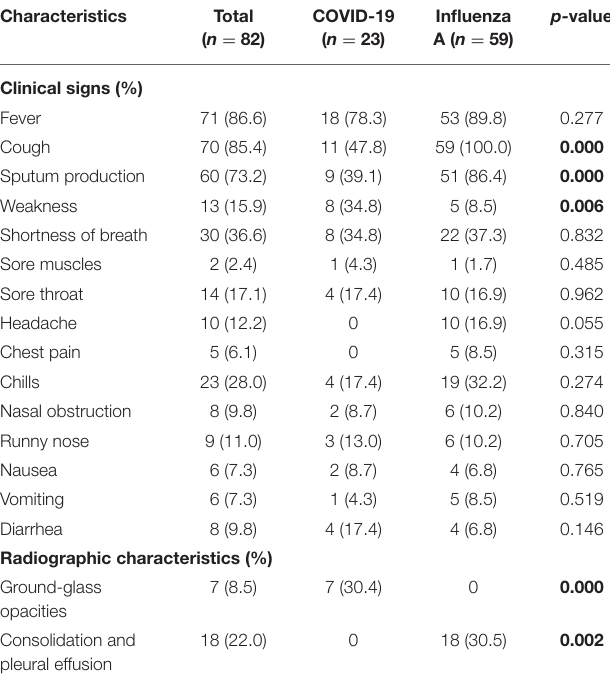
TABLE 3 | Clinical symptoms of patients with COVID-19 and influenza-A. Characteristics